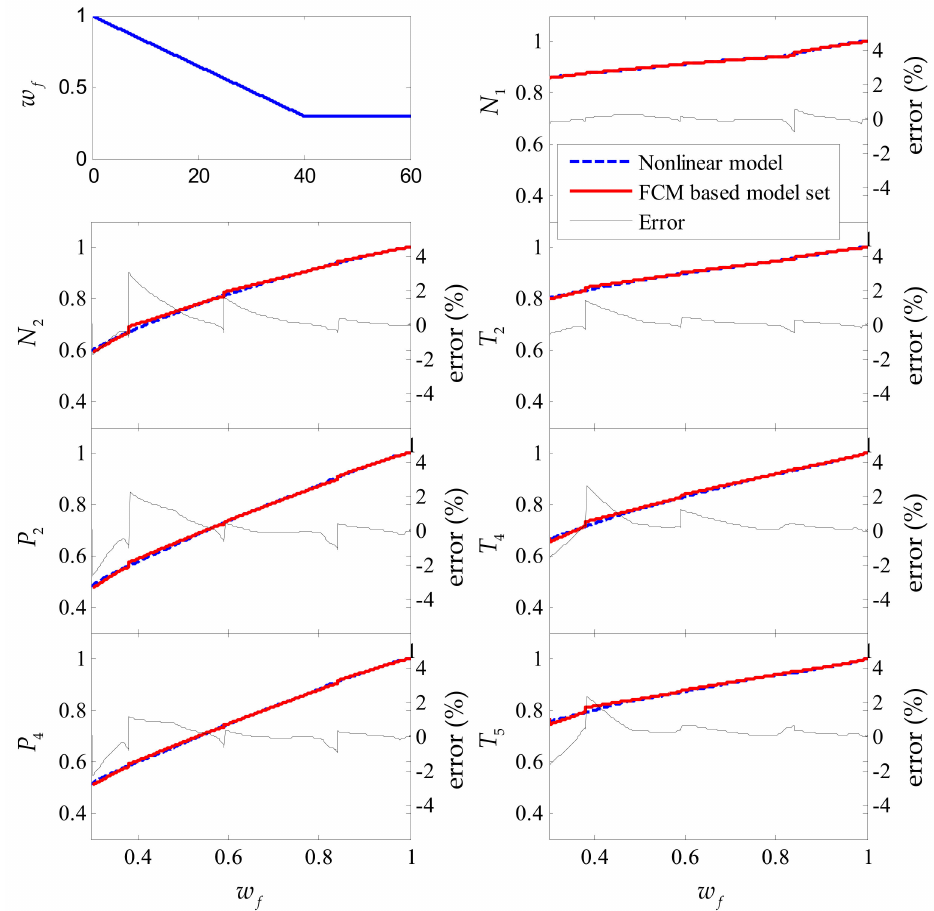
Figure 6. Comparison of the response of each measurement parameter between the nonlinear model and the FCM based model set at a given fuel flow schedule, and the corresponding